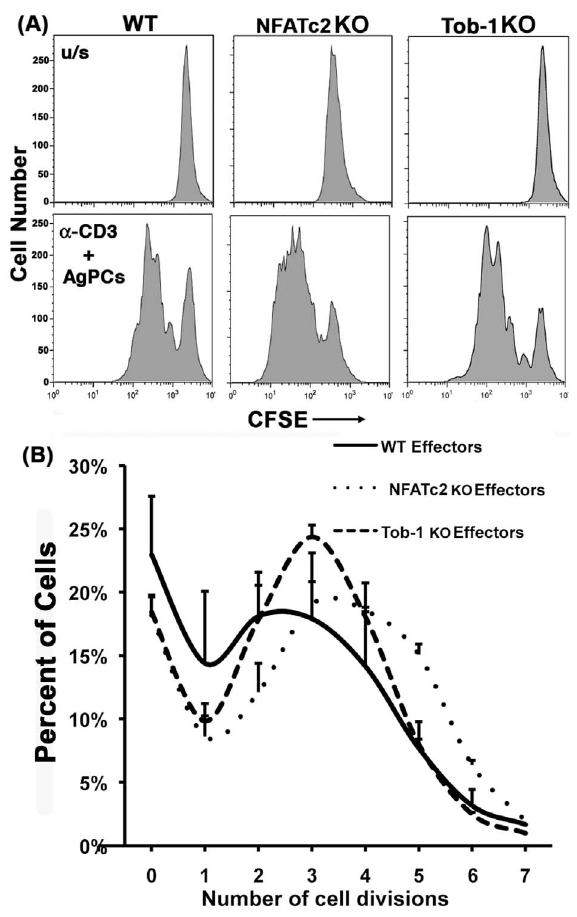
Figure 4. Nfatc2 and Tob1 KOs lead to hyper-proliferative T-cell responses invitro . CD4 T cells were isolated from single cell suspensions of spleens and lymph nodes of age-matched WT, Nfatc2 KO, and Tob1 KO mice by negative immunomagnetic selection. CD4 + CD25 2 (Tconv) cells were then enriched by depletion of CD4 + CD25 + (Treg) cells and labeled with CFSE. Tconv cells were mixed 1:1 with syngeneic CD19 + spleen cells (AgPCs) and stimulated with anti- CD3 (1 ng/ml). Proliferation was measured by CFSE dilution in CD4 T cells using flow cytometry after of 96 hr of culture. (A) Representative one-dimensional histograms of CFSE dilution from unstimulated (top) or from stimulated (bottom) WT, Nfatc2 KO and Tob1 KO T cells from one experiment using pooled spleen cells from 3 mice each. (B) Means 6 S.D. of the percent of cells that underwent 0–7 divisions over 96 hr for each genotype. The data summarize 8, 4, and 3 experiments using triplicate samples of WT cells, Nfatc2 KO cells, and Tob1 KO cells, respectively, each with pooled cells from 2 or 3 mice.